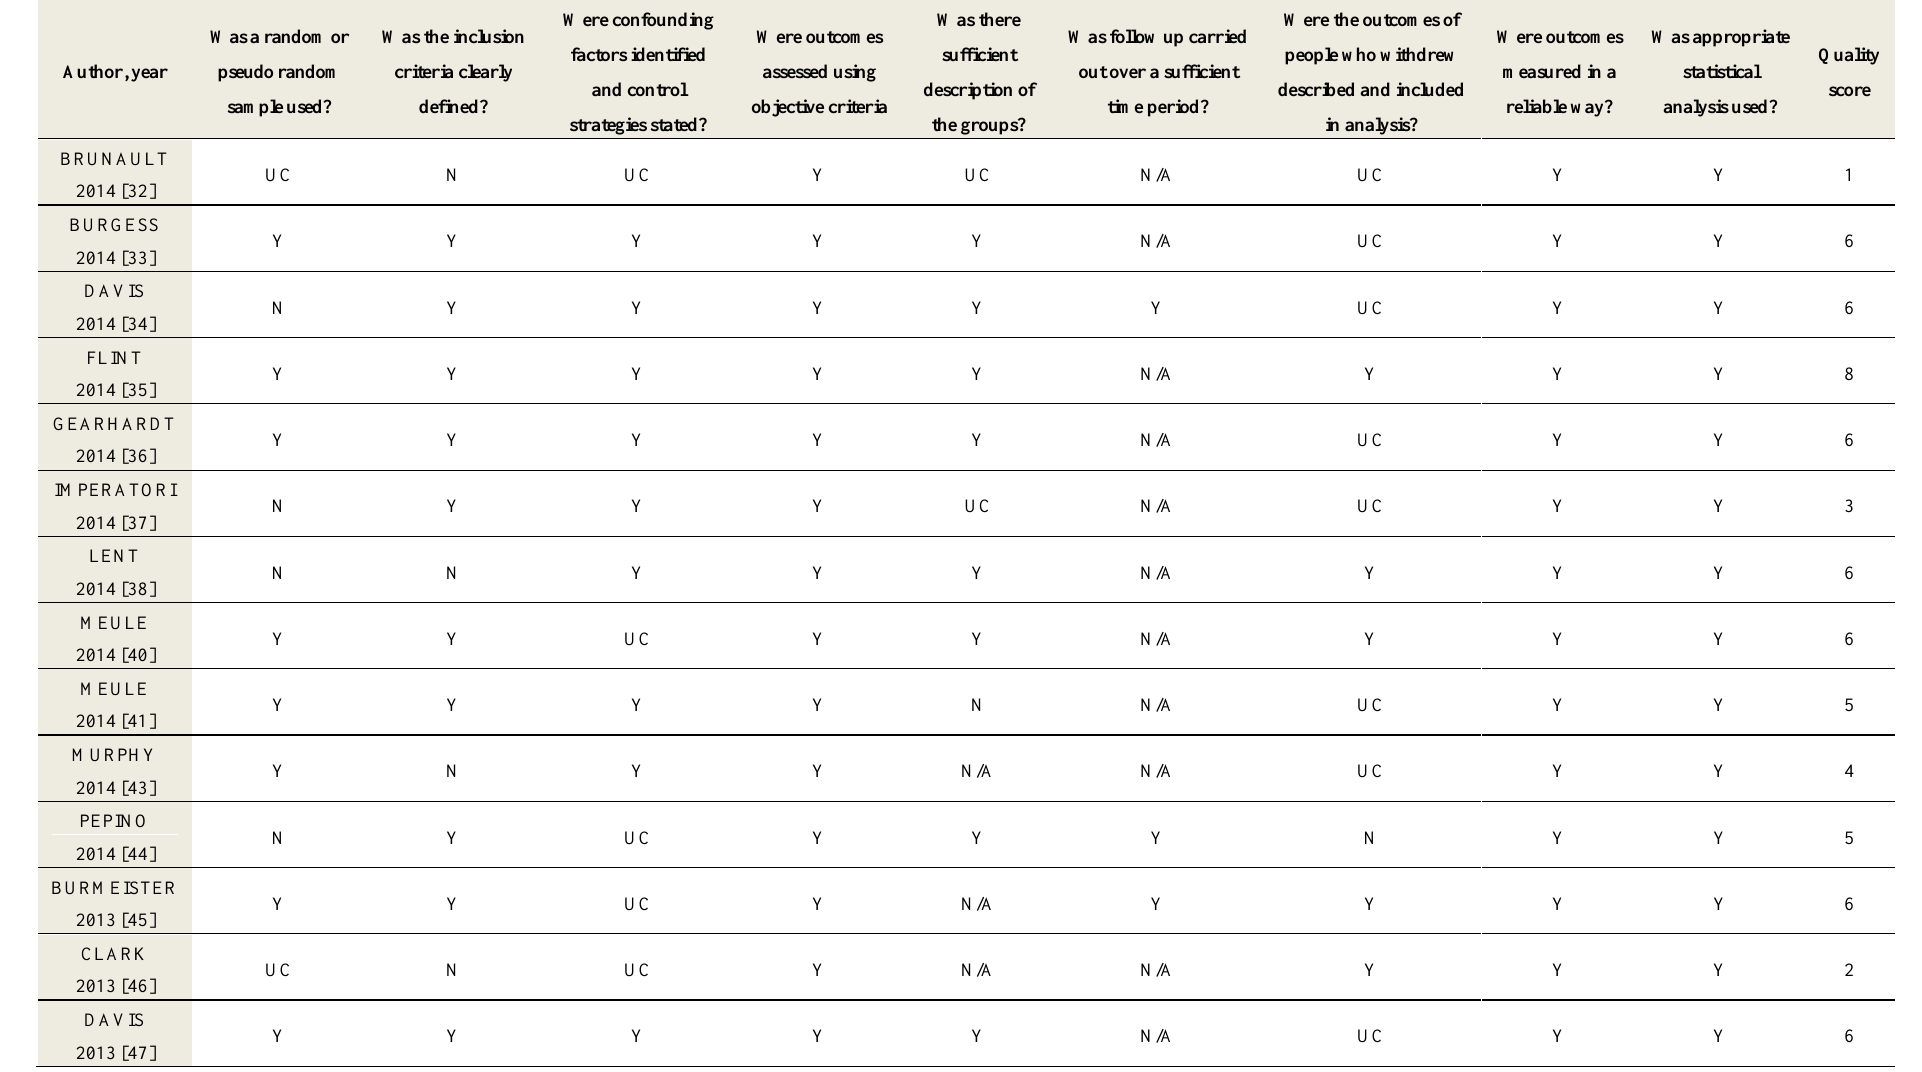
Table 2. Quality assessment of the studies reviewed